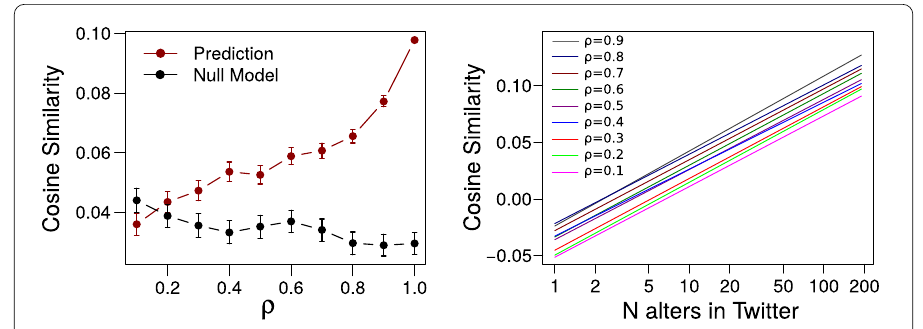
Figure 5 Biography cosine similarity in predictions as a function of disclosure tendency and number of friends. The left panel shows the median cosine similarity of predictions and of the Null Model in 1000 samples for each value of ρ with bars showing 95% bootstrapping confidence intervals. The cosine similarity of predictions outperforms the Null Model for ρ > 0.2 and increases with ρ . The right panel shows the regression analysis of cosine similarity versus number of friends in Twitter, revealing a trend of increasing similarity with number of friends for the different values of ρ